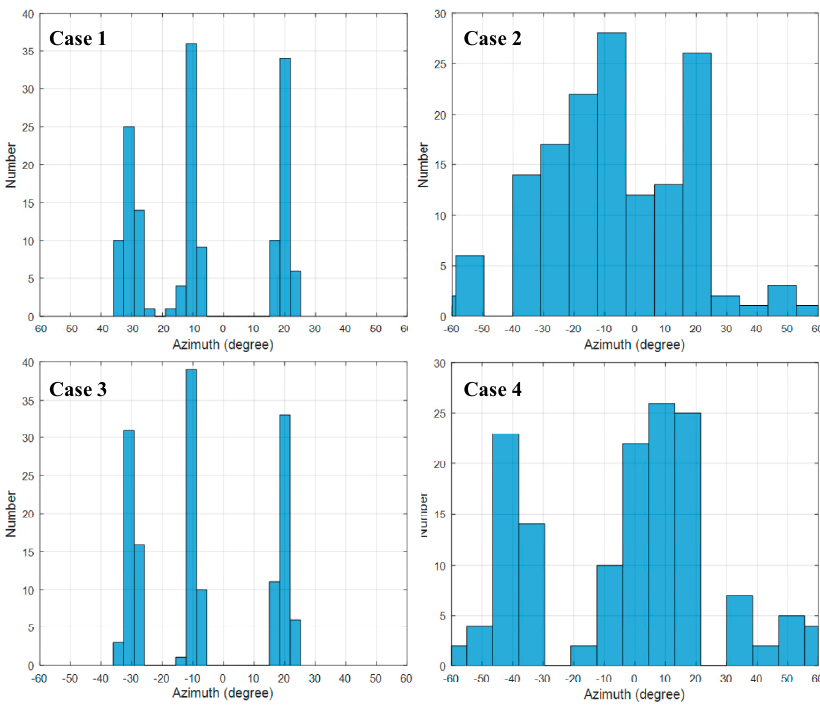
Figure 8. Statistical histogram of azimuth spectrum synthesis.